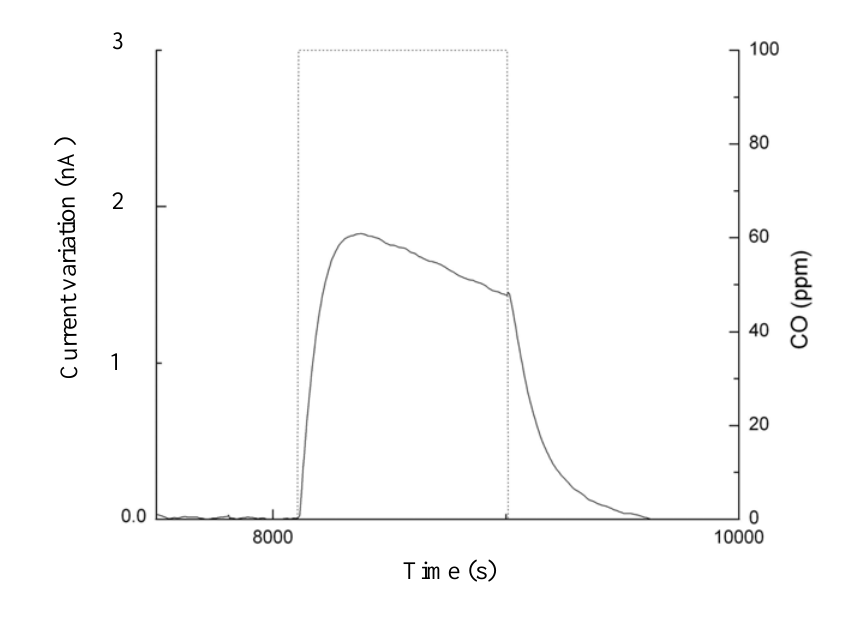
Figure 6. Dynamical response to a square pulse of 100 ppm of CO. Current rises up due to redox reactions at surface. The characteristic response time of a layer is visible.